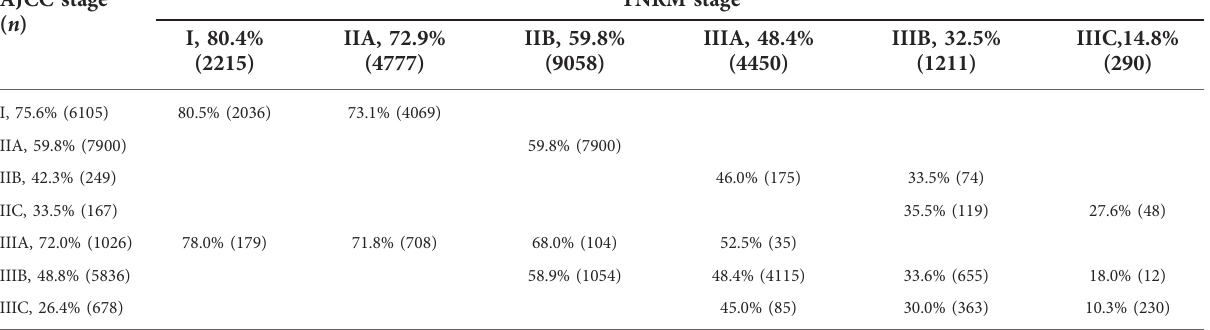
TABLE 6 Five-year overall survival by AJCC staging and TNRM staging for predicting the survival of CRC patients in the training set from SEER.